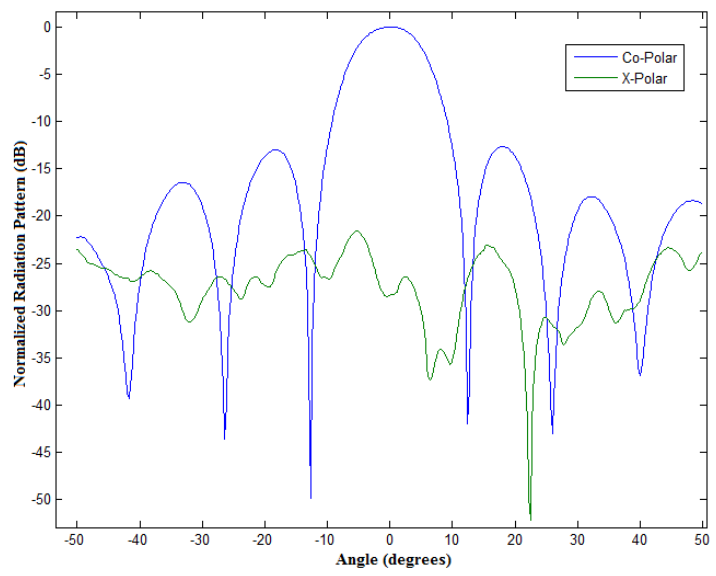
Figure 13. The azimuth principal plane cut of measured co-polar and cross-polar patterns of an eight-by-eight planar phased array antenna (based on AEPs and software